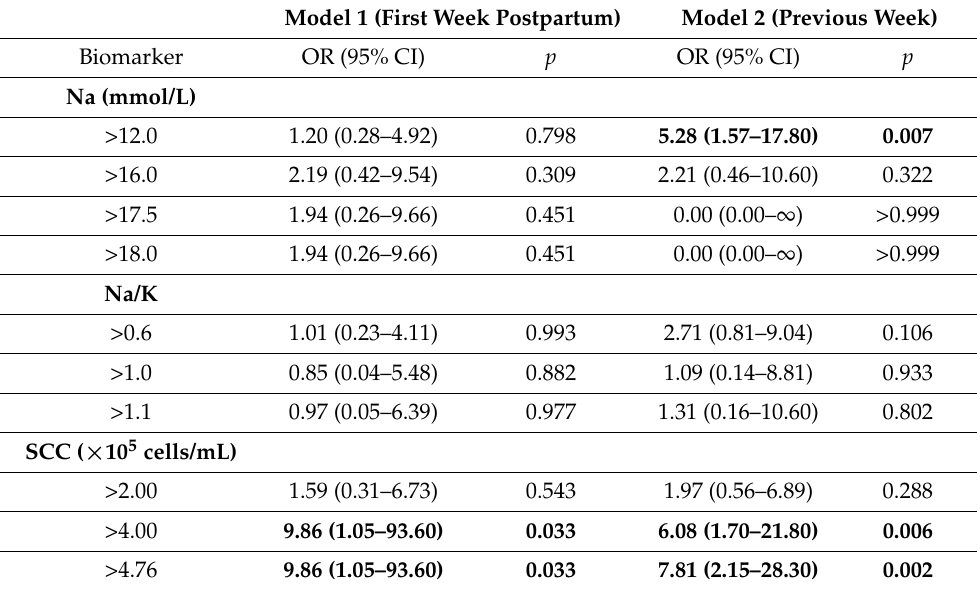
Table 2. Likelihood of developing clinical mastitis during the first 6 weeks postpartum based on Na concentration, Na/K, and SCC in milk produced during the first week postpartum (model 1) or in the week prior to mastitis onset (model 2).